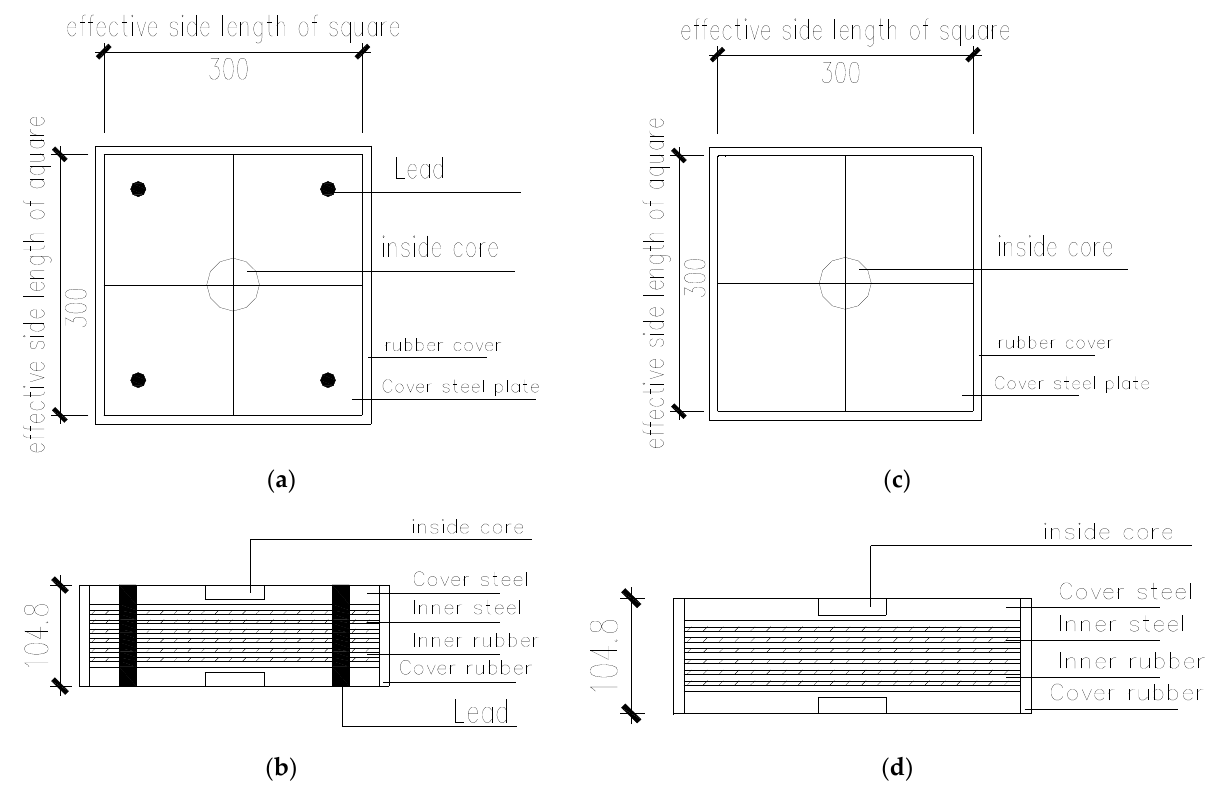
Figure 1. Details of isolator: ( a ) planar view (LRB); ( b ) top-down view (LRB); ( c ) planar view (SHDR); ( d ) top-down view (SHDR).